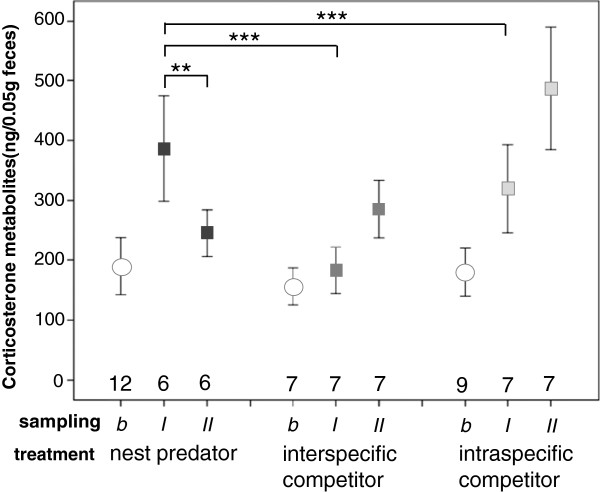
Amount of corticosterone metabolites in the fecal samples of common vole mothers (Microtus arvalis). Mothers were either treated with a nest predator (NP, shrew, Crocidura russula), an interspecific resource competitor (RC, field vole, M. agrestis) or an intraspecific competitor control individual (C). Samples were taken at three reproductive phases (sampling b, I, II) within one reproduction cycle of each female common vole. b: baseline; taken after 3 days of habituation to enclosures (at day 15 of common voles’ pregnancy) before treatment. I: Sample taken around parturition and 3 days after adding treatment animals to enclosures (at day 18 of pregnancy). II: Sample taken with having 5 days old nestlings.